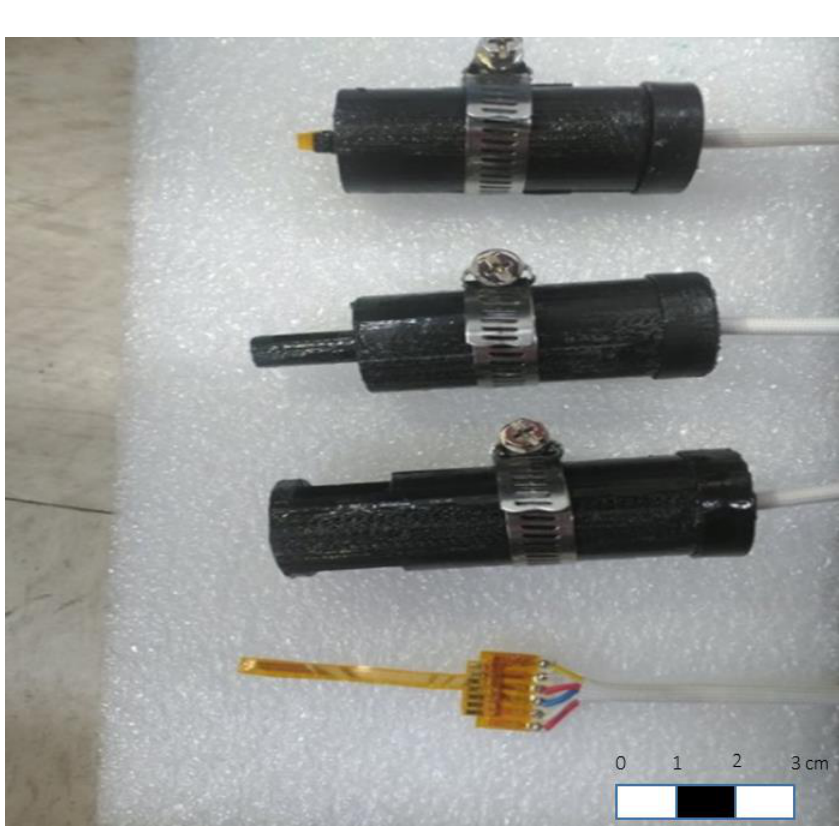
Figure 4. Image of finished product after packaging.